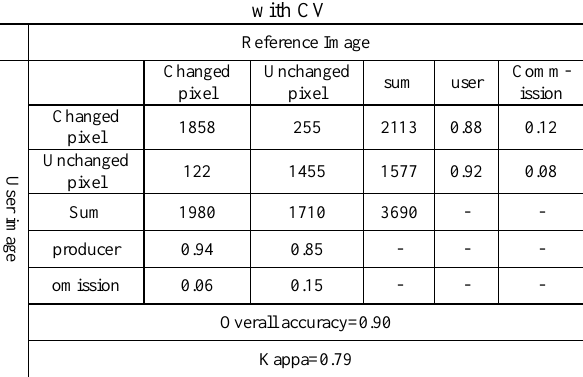
Table 13. Error matrix of object-oriented method with